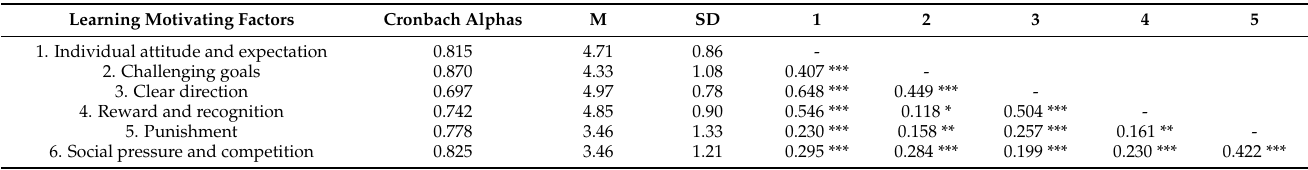
Table 1. The learning motivating factors questionnaire: descriptive statistics and correlations between the subscales. Learning Motivating Factors